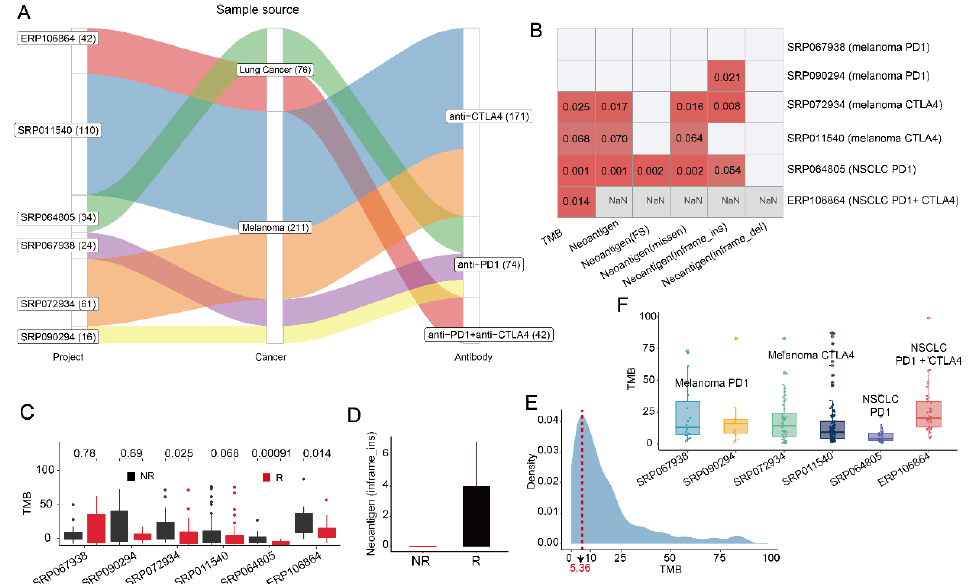
Figure 1. Mutation landscape of samples from different projects. ( A ). Sankey plot of detailed information of data collected in this project. ( B ). Correlation of TMB, neoantigen and neoantigen from different types of mutations with patient response. “NaN” indicates no neoantigen results in NSCLC treated by the combination of anti-PD1 and anti-CLTA4 (the raw sequence data not available). ( C ). Boxplots of TMB between responders and non-responders in different cohorts. TMB was significantly higher in responders of melanoma treated with anti-CTLA4 and NSCLC samples (Mann-Whitney U test p -value < 0.05). ( D ). Boxplot of neoantigens from in-frame insertion mutation between responders and non-responders in anti-PD1 treated melanoma samples. ( E ). Density profile of TMB in all samples. ( F ). Boxplots of TMB in samples of two anti-PD1 treated melanoma cohorts, two anti-CTLA4 treated melanoma cohorts, NSCLC treated by anti-PD1, and the combination of anti-PD1 and anti-CTLA4.